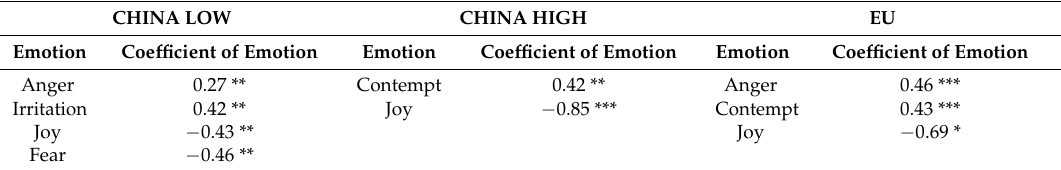
Table 5. Relation between responders’ destruction and